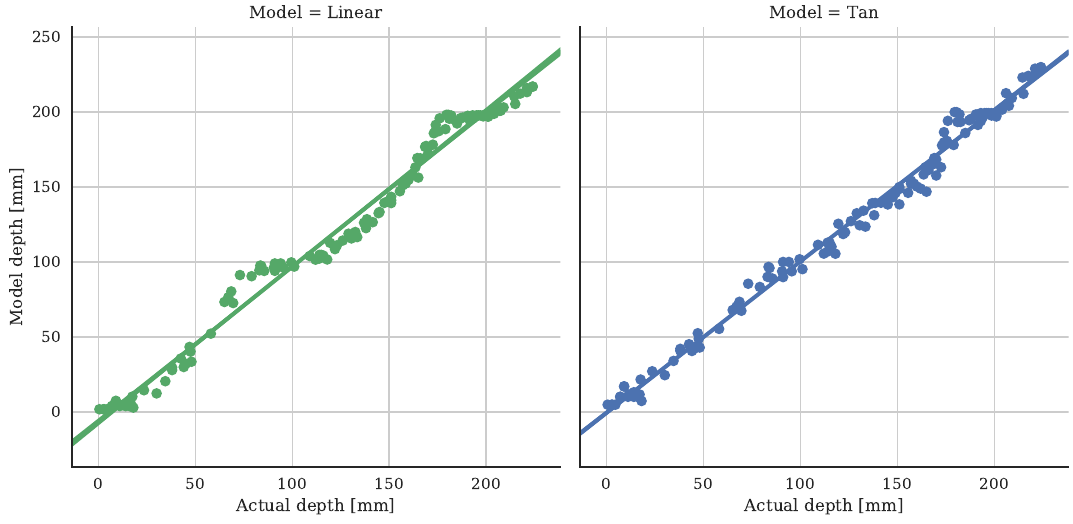
Figure 7. Regression plot of the modeled vs actual water depths from the rice field. The R 2 of the linear model is 0.985, and that of the tangent model is